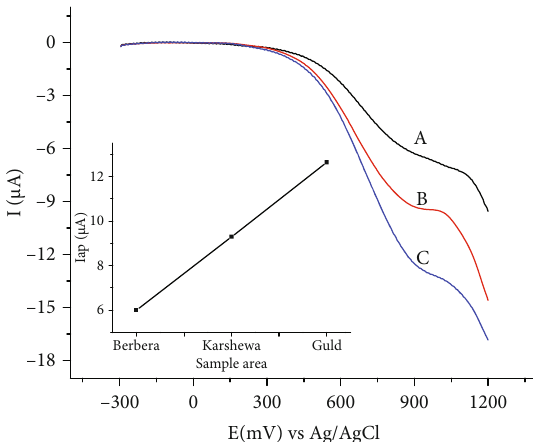
Figure 8: SWVs of AQMCPE in pH 4 PBS containing various concentrations of AA (a – h: 0.05, 0.1, 0.2, 0.5, 1.0, 1.5, 2.0, and 4.0mM, respectively). Experimental conditions: frequency 35Hz, amplitude 30mV, step potential 7 mV. Inset: plot of oxidative peak current vs. concentration of AA.